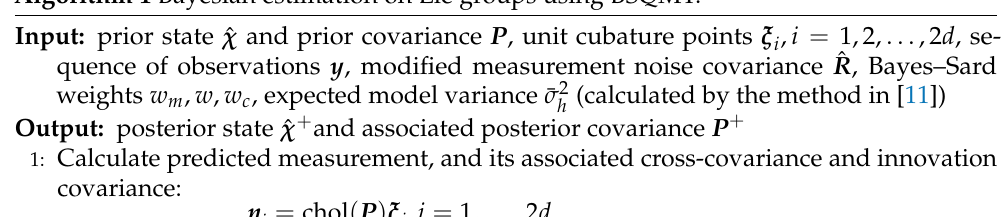
Algorithm 1 Bayesian estimation on Lie groups using